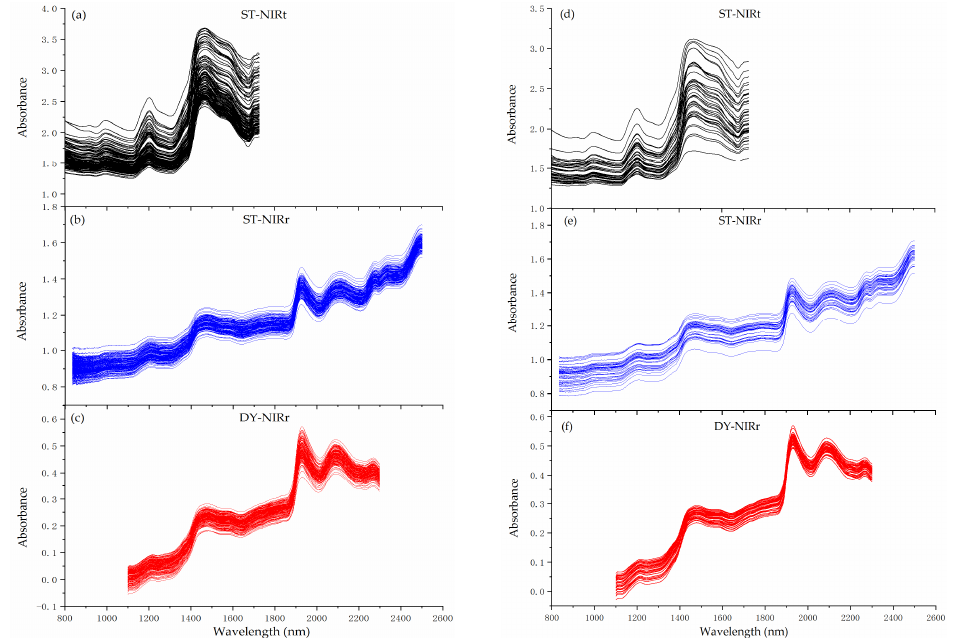
Figure 4. Spectra of single rice kernel AC ( a – c ) and FC ( d – f ) datasets under different measurement conditions. (Note: the black, blue, and red curves in the figures represent the spectra measured on the conditions of ST-NIRt, ST-NIRr, and DY-NIRr).